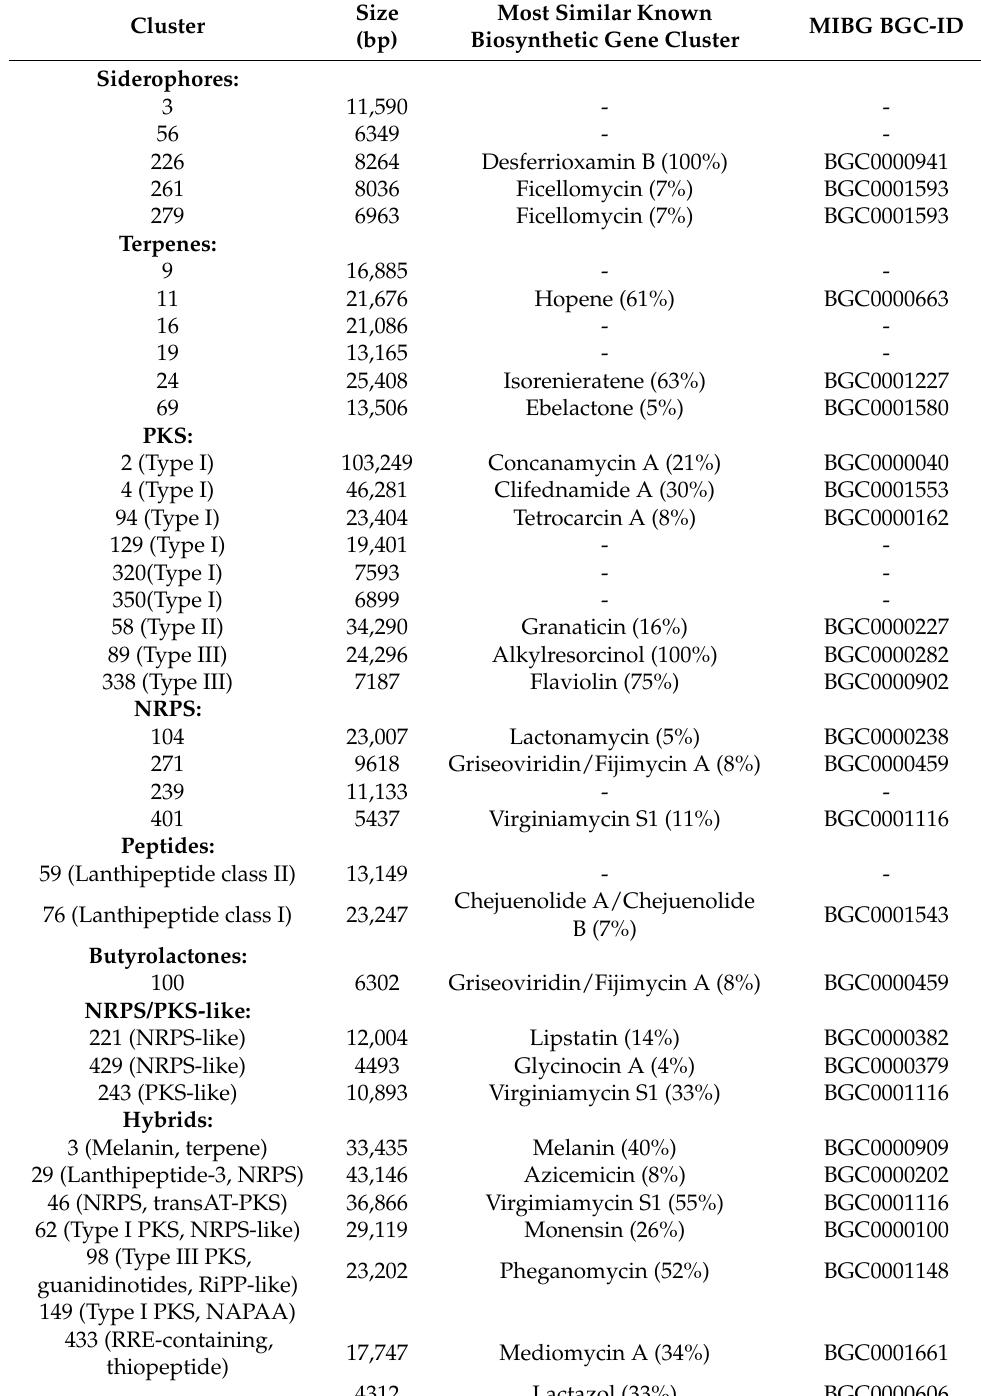
Table 3. List of putative secondary metabolites producing biosynthetic gene clusters as predicted by